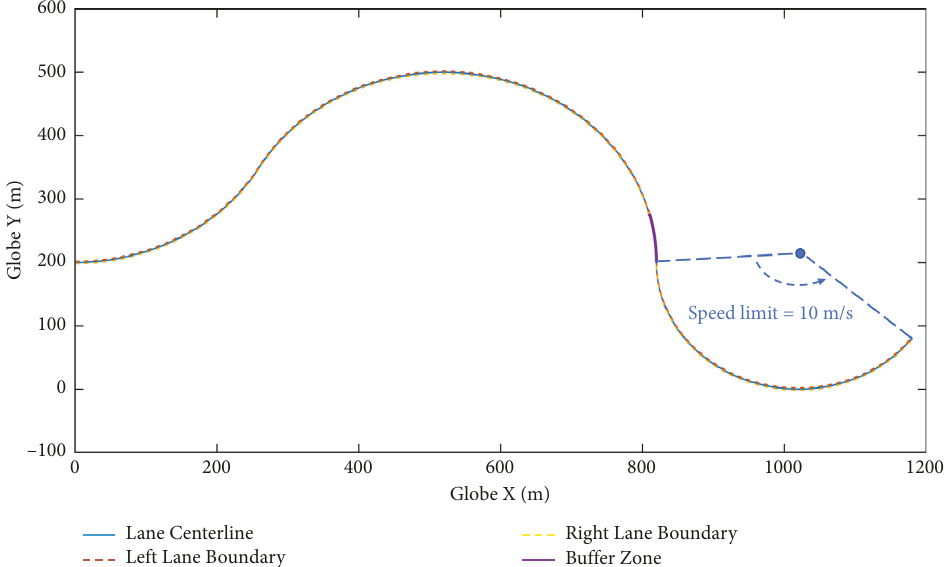
Figure 7: Illustration of road trajectory with a “buffer zone.”